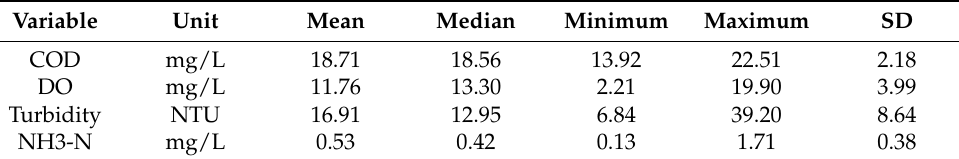
Table 3. Summary statistics of the main variables of data set (88 groups).